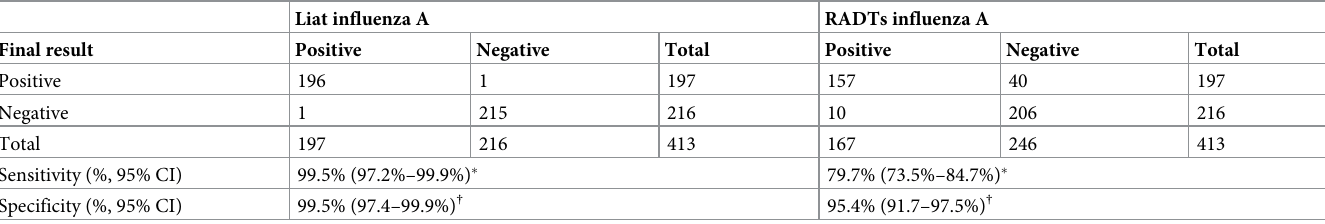
Table 2. Clinical performance of the Liat test compared with RADTs for influenza A detection.